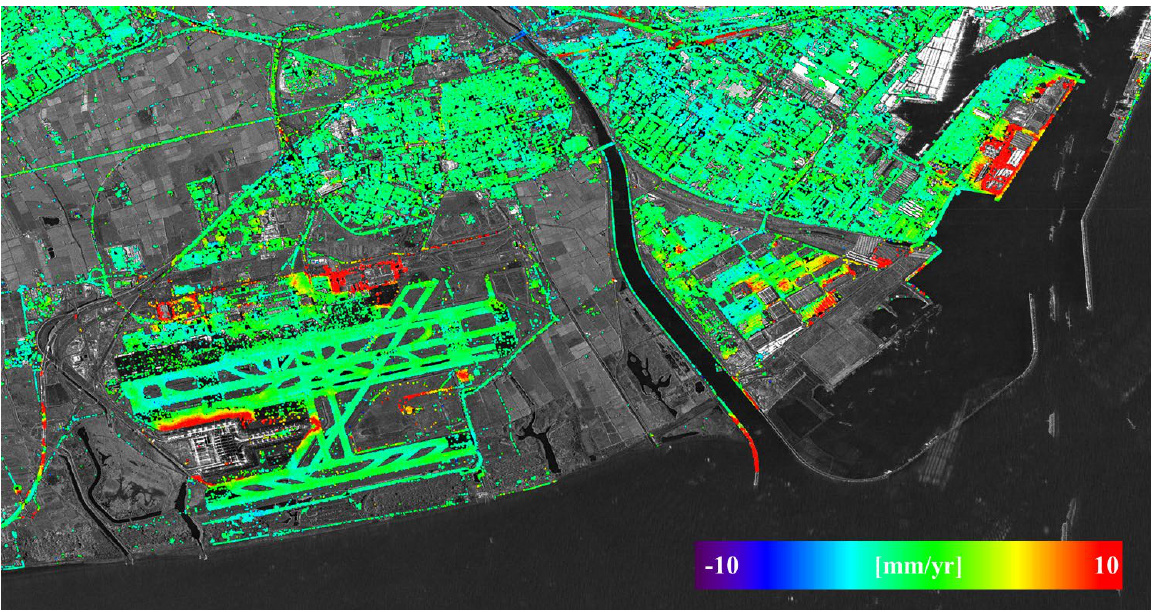
Figure 1: Example of A-DInSAR result (deformation velocity). The measurement points are mainly concentrated over structures and infrastructures, while over the vegetated area the coverage is very